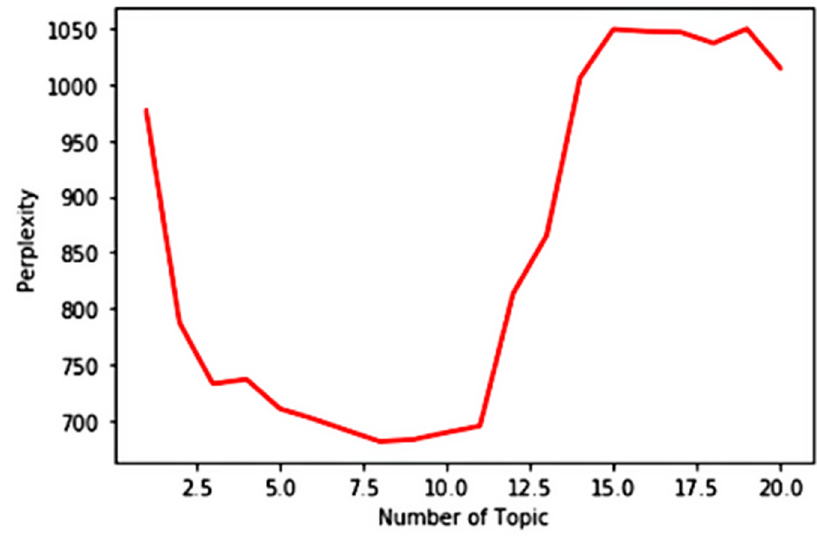
Figure 2. Confusion Degree Curve of Subject Quantity. Data source: self sorting and drawing.